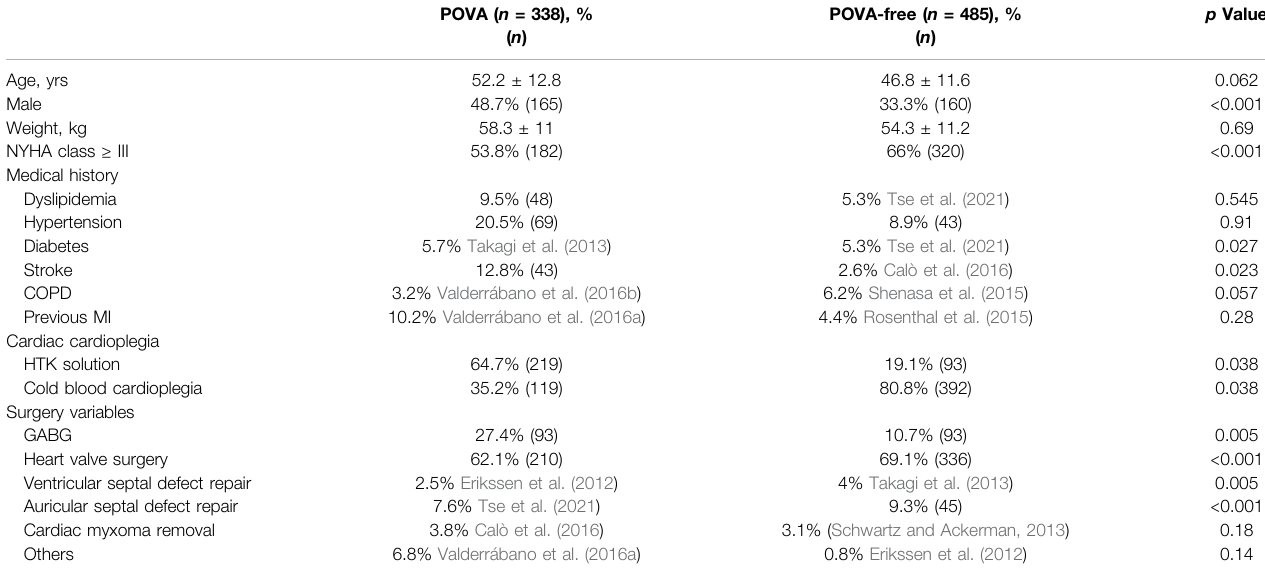
TABLE 1 | Baseline Characteristics in patients with POVA and